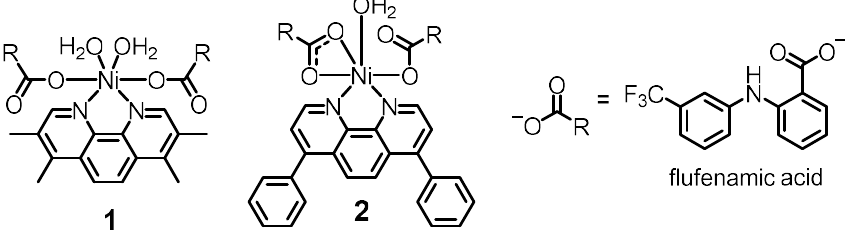
Figure 1. Chemical structures of nickel(II)-flufenamic acid complexes with 3,4,7,8-tetramethyl-1,10- phenanthroline or 4,7-diphenyl-1,10-phenanthroline ( 1 and 2 ) prepared and investigated in this study.